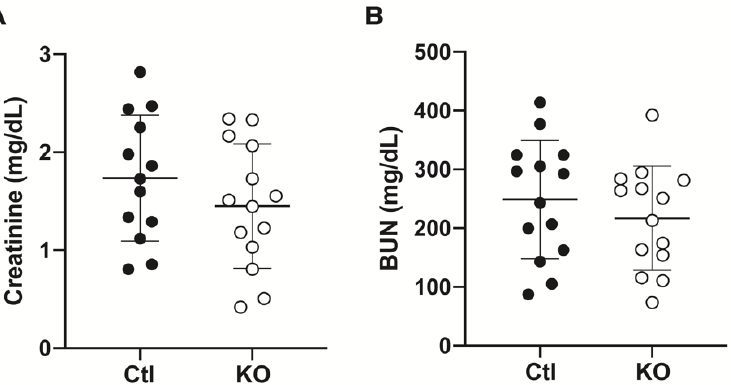
Figure 2. Serum markers of kidney injury do not differ between control animals and animals lacking endothelial expression of the γ subunit of ENaC after IRI. Serum collected from control and knockout animals after 48 h of reperfusion showed no significant difference in levels of creatinine ( A ) or blood urea nitrogen ( B ). n = 13 to 14 for each measure; data represented as mean ± SD; unpaired t-tests performed to determine existence of difference with definition of statistical significance set at p < 0.05.